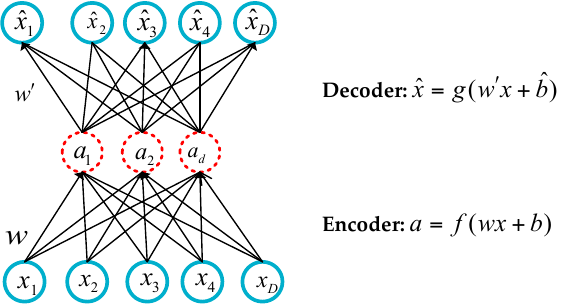
Figure 5. Structure of a typical autoencoder model.